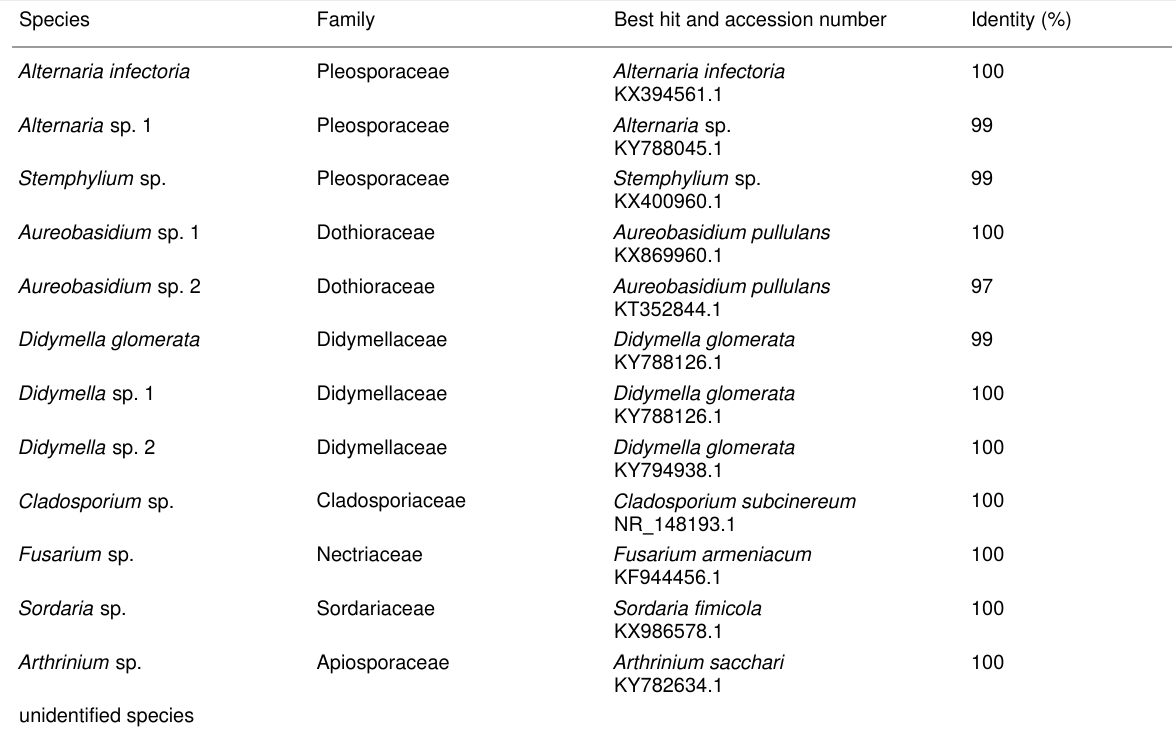
Table 1: Fungal endophytes identified from leaves of mature black poplar ( Populus nigra ) trees. a